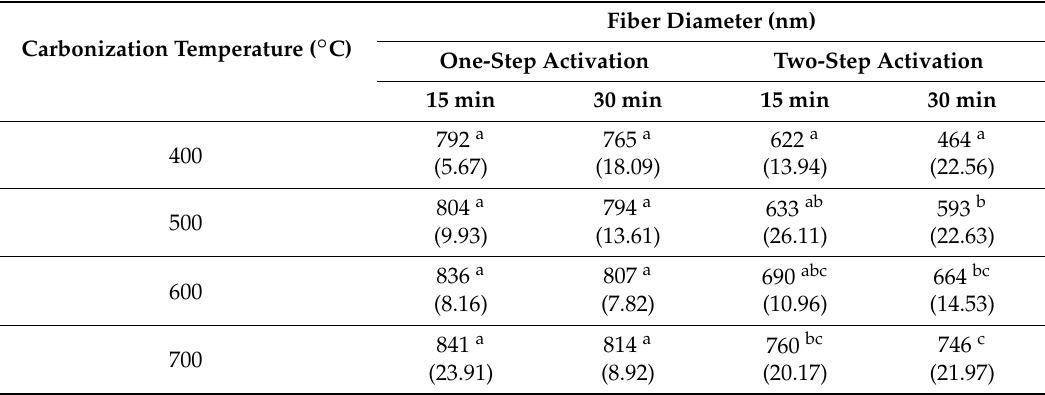
Table 2. Diameter of produced LACFs.